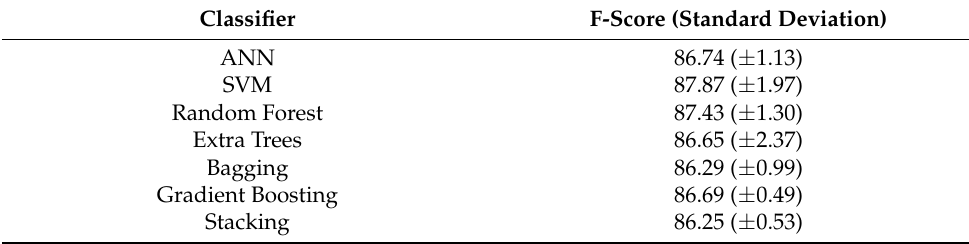
Table 4. F-score results for all classifiers.